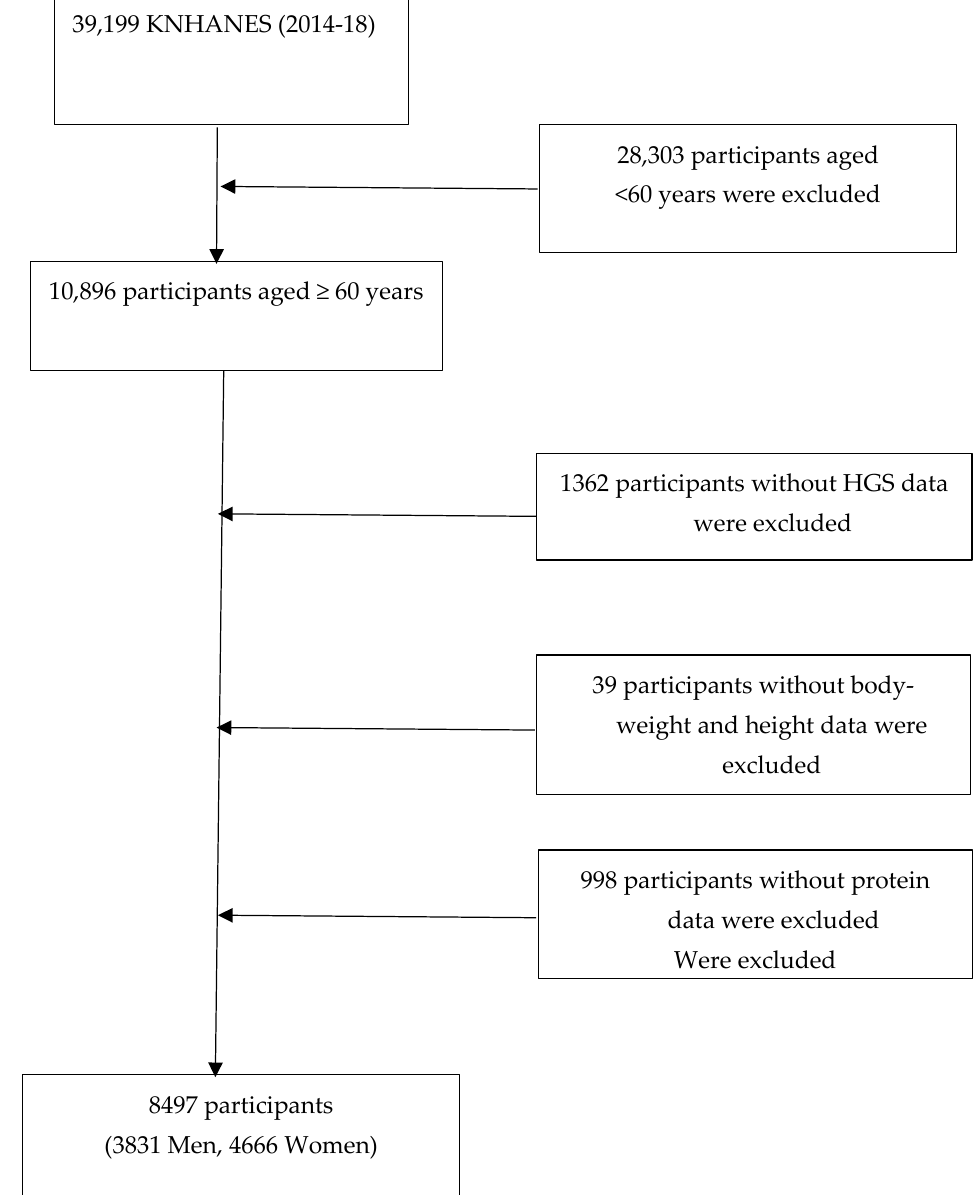
Figure 1. Flow diagram of study participant selection. KNHANES, Korean National Health and Nutrition Examination Survey; HGS, handgrip strength.